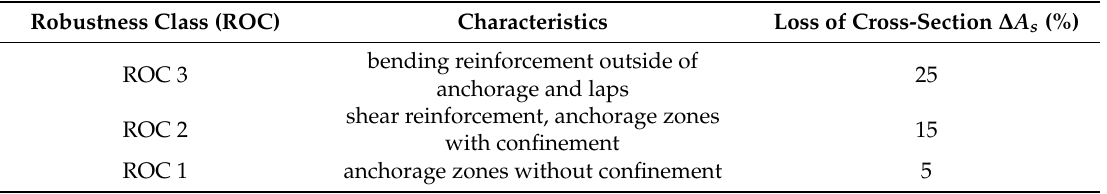
Table 4. Robustness classes (ROC) in relation to cross-section loss